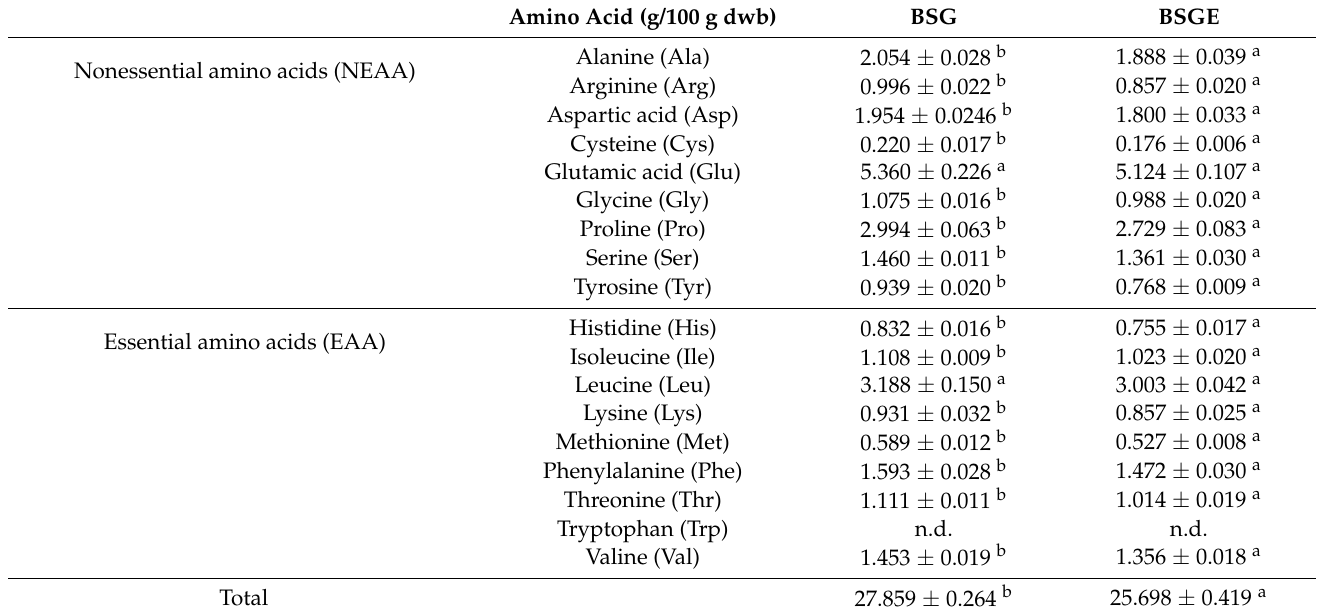
Table 4. Amino acid composition of BSG and